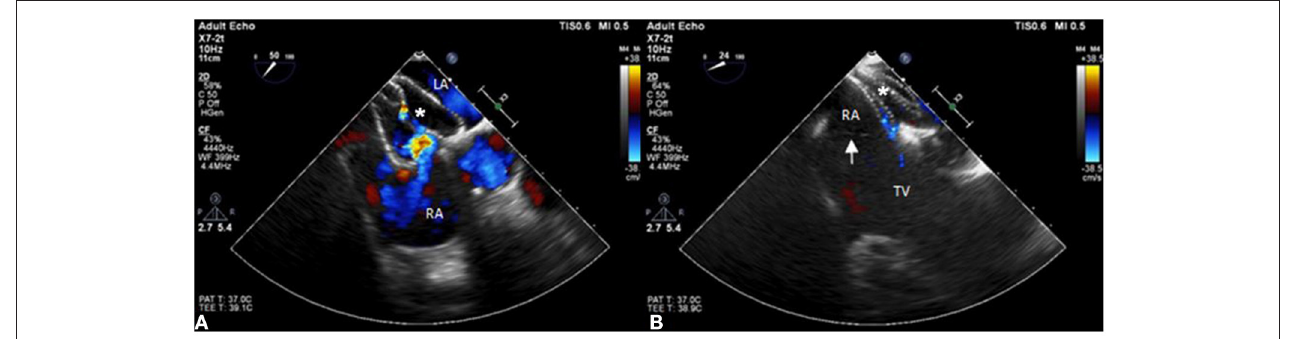
FIGURE 4 | The position of the ASD occluder. (A) The position of the ASD device is initially incorrect with part of the incomplete cor triatiatum dexter clamped and many residual shunts noted under TEE. (B) The position of the ASD occluder is good with a minimal residual shunt and the incomplete cor triatiatum dexter (arrow) is free from clamping by the